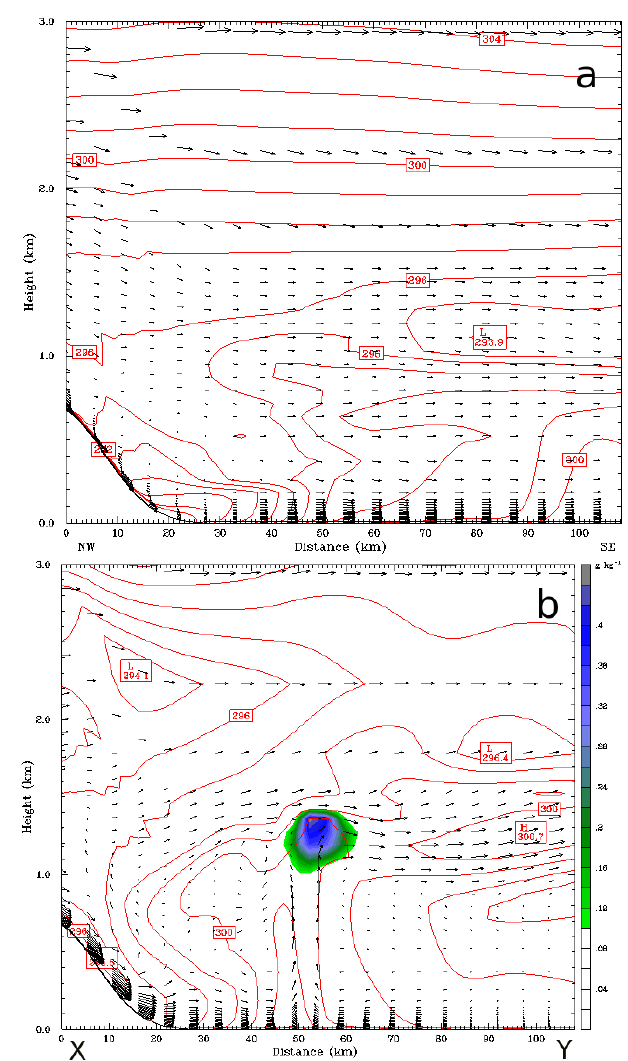
Figure 5. Simulated vertical cross sections along the yellow line of Fig. 1 of the wind field (arrows), equivalent potential temperature (red lines) and cloud mixing ratio (color contour) at 04:00UTC on (a) 13 December and (b) 15 December. The maximum wind speed is 8.1 m s − 1 and 6.5 m s − 1 in the upper and lower panels, respectively. Table 1. Relation between the atmospheric conditions according MM5 simulation and radar observation. Night Sim. Sim. Sim. Sim. Radar div < 0 Rotor NLLJ q cl > 0 precip.